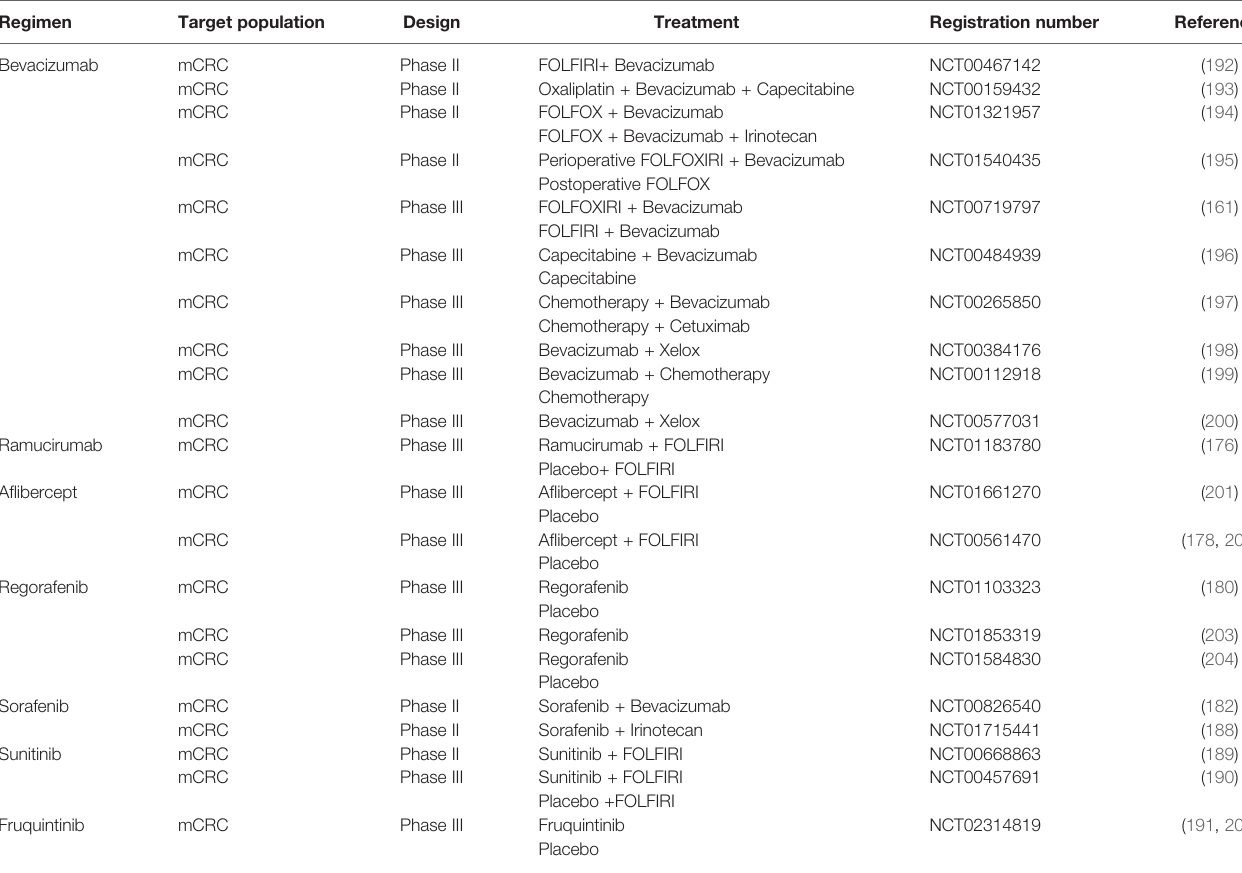
TABLE 1 | Summary of antiangiogenic therapy for colorectal cancer (CRC).